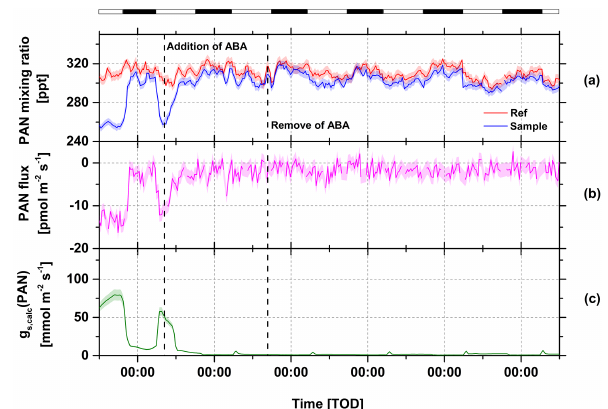
Figure 11. O 3 mixing ratio (a) , O 3 flux (b) and stomatal conduc- tance to O 3 (c) measured at Quercus ilex treated with 250µM ABA- nutrient solution. The diurnal cycle of light was simulated by a cli- mate cabinet with 13h light period (white balk) and 11h dark period (black balk). RH inside both cuvettes was around 40%.